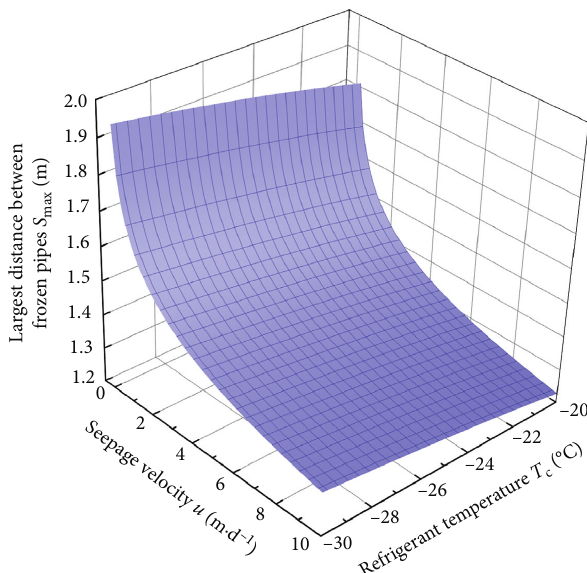
Figure 8: The relation diagram of S